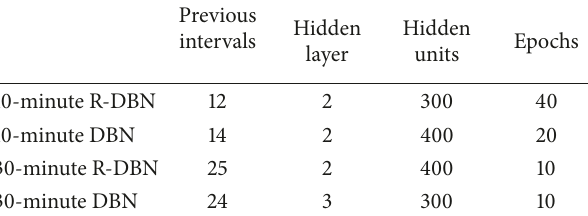
Figure 4: Graph of the experiment area. Table 1: The most effective architecture.